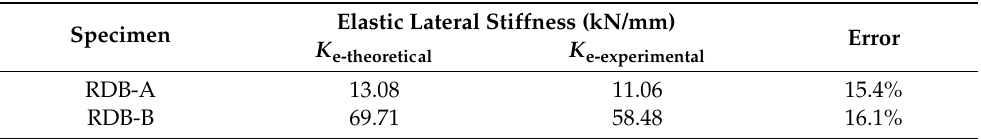
Table 3. Comparison of elastic stiffness of the theoretical and experimental test results.